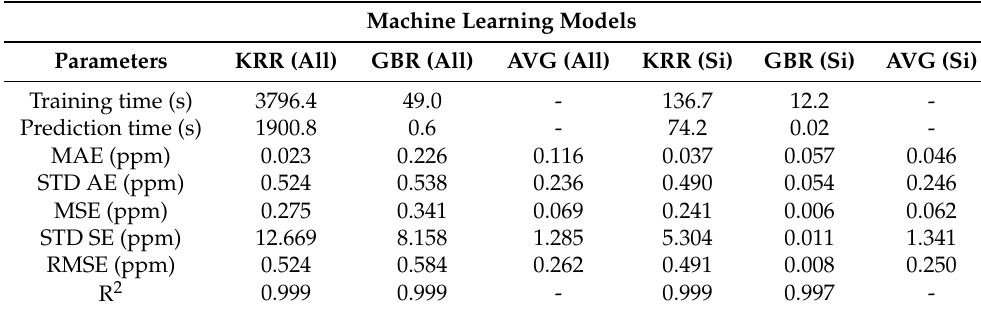
Table 1. Training and prediction time, mean absolute error (MAE), root-mean-squared error (RMSE), the R 2 coefficient of the KRR and GBR model predictions together with the average of both predicted values (AVG). The data shown are only for the Si atoms (Si) and all atoms (All) in the